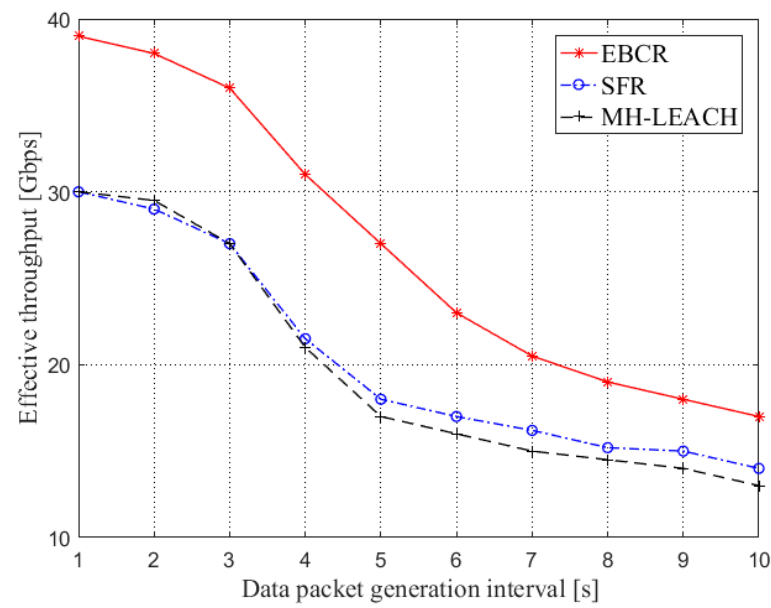
Figure 16. Comparison of effective throughput.